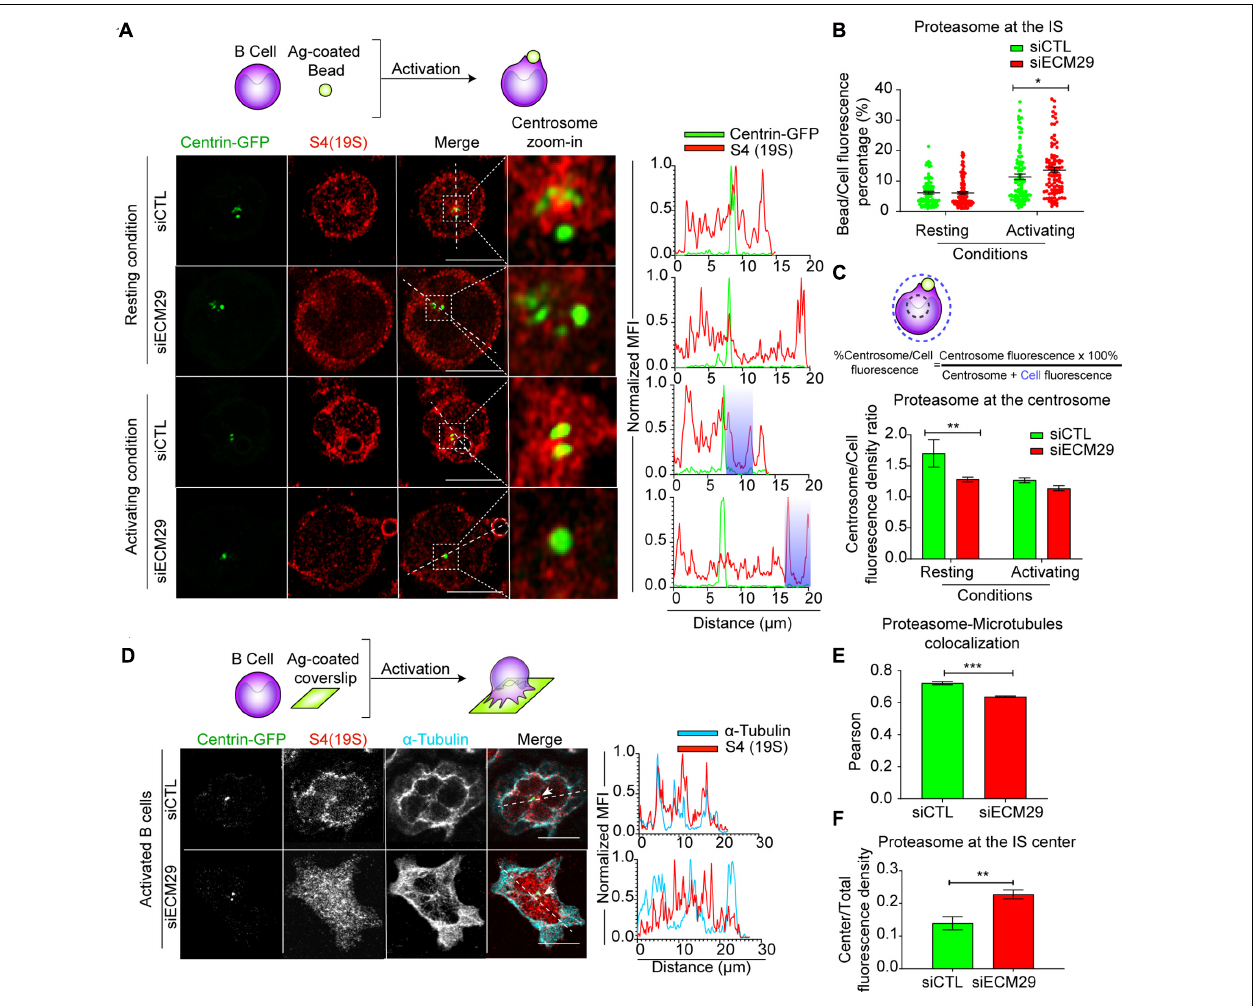
FIGURE 2 | Ecm29 regulates proteasome localization at the centrosome and microtubules: (A) Top: Schematic representation of B cells activated with antigen-coated beads. Representative confocal images of centrin-GFP expressing control (siCTL) and Ecm29-silenced (siECM29) B cells in resting (0 min) or activating (60 min) conditions, labeled for 19S[S4] (red). Magnifications of the centrosome area (3 µ m 2 ) are shown. Fluorescence intensity distributions of centrin-GFP (green) and S4(19S) (red) across the cell (dashed white lines) are shown on the right. White dashed circles and shaded areas represent the bead and the centrosome area, respectively. (B,C) Scheme and quantification of proteasome enrichment at the centrosome and the bead in (A) , respectively. N = 4. Cells > 97. (D) Schematic representation of B cells activated onto antigen-coated coverslips. Representative confocal images of centrin-GFP expressing control and Ecm29-silenced B cells after 60 min of activation, labeled for 19S[S4] and α -tubulin. The fluorescence intensity distributions of α -tubulin (blue) and S4(19S) (red) across the cell (dashed white lines) are shown. White arrows indicate the centrosome. (E,F) Quantification of proteasome colocalization with microtubules and proteasome recruitment at the IS center, respectively. N = 2. Cells > 53 and > 48, respectively. * p < 0.05. ** p < 0.01. *** p < 0.001. Kruskal–Wallis test with Dunn’s test, and Mann–Whitney test was performed for all statistical analyses. Mean with SEM bars are shown. Scale bar = 10 µ